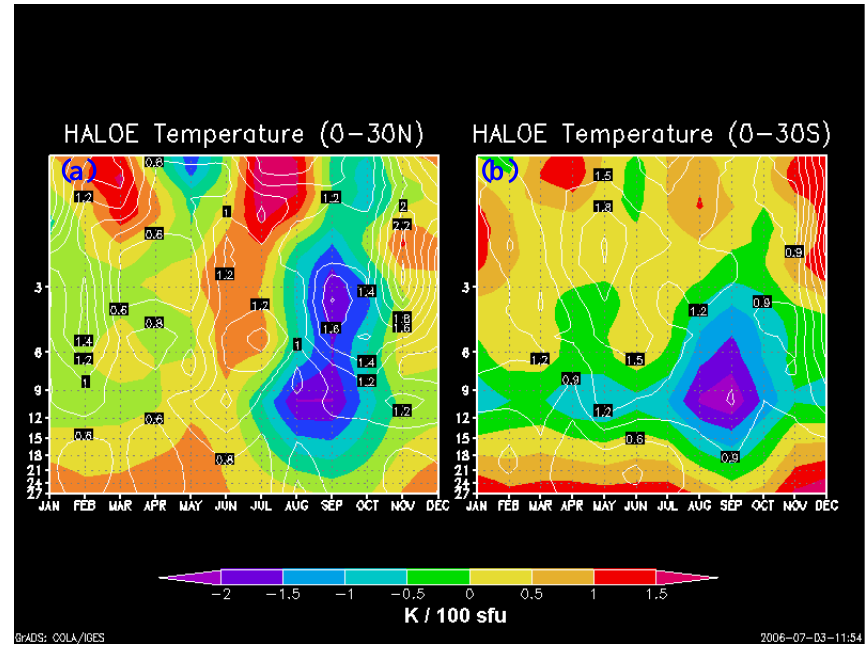
Fig. 6. Vertical distribution of the monthly variation of the solar coefficient (K/100 sfu) obtained from HALOE temperature (a) 0–30 ◦ N (b) 0–30 ◦ S. Monthly variation of 1 sigma error in the solar effect on temperature is over-plotted with thin lines.